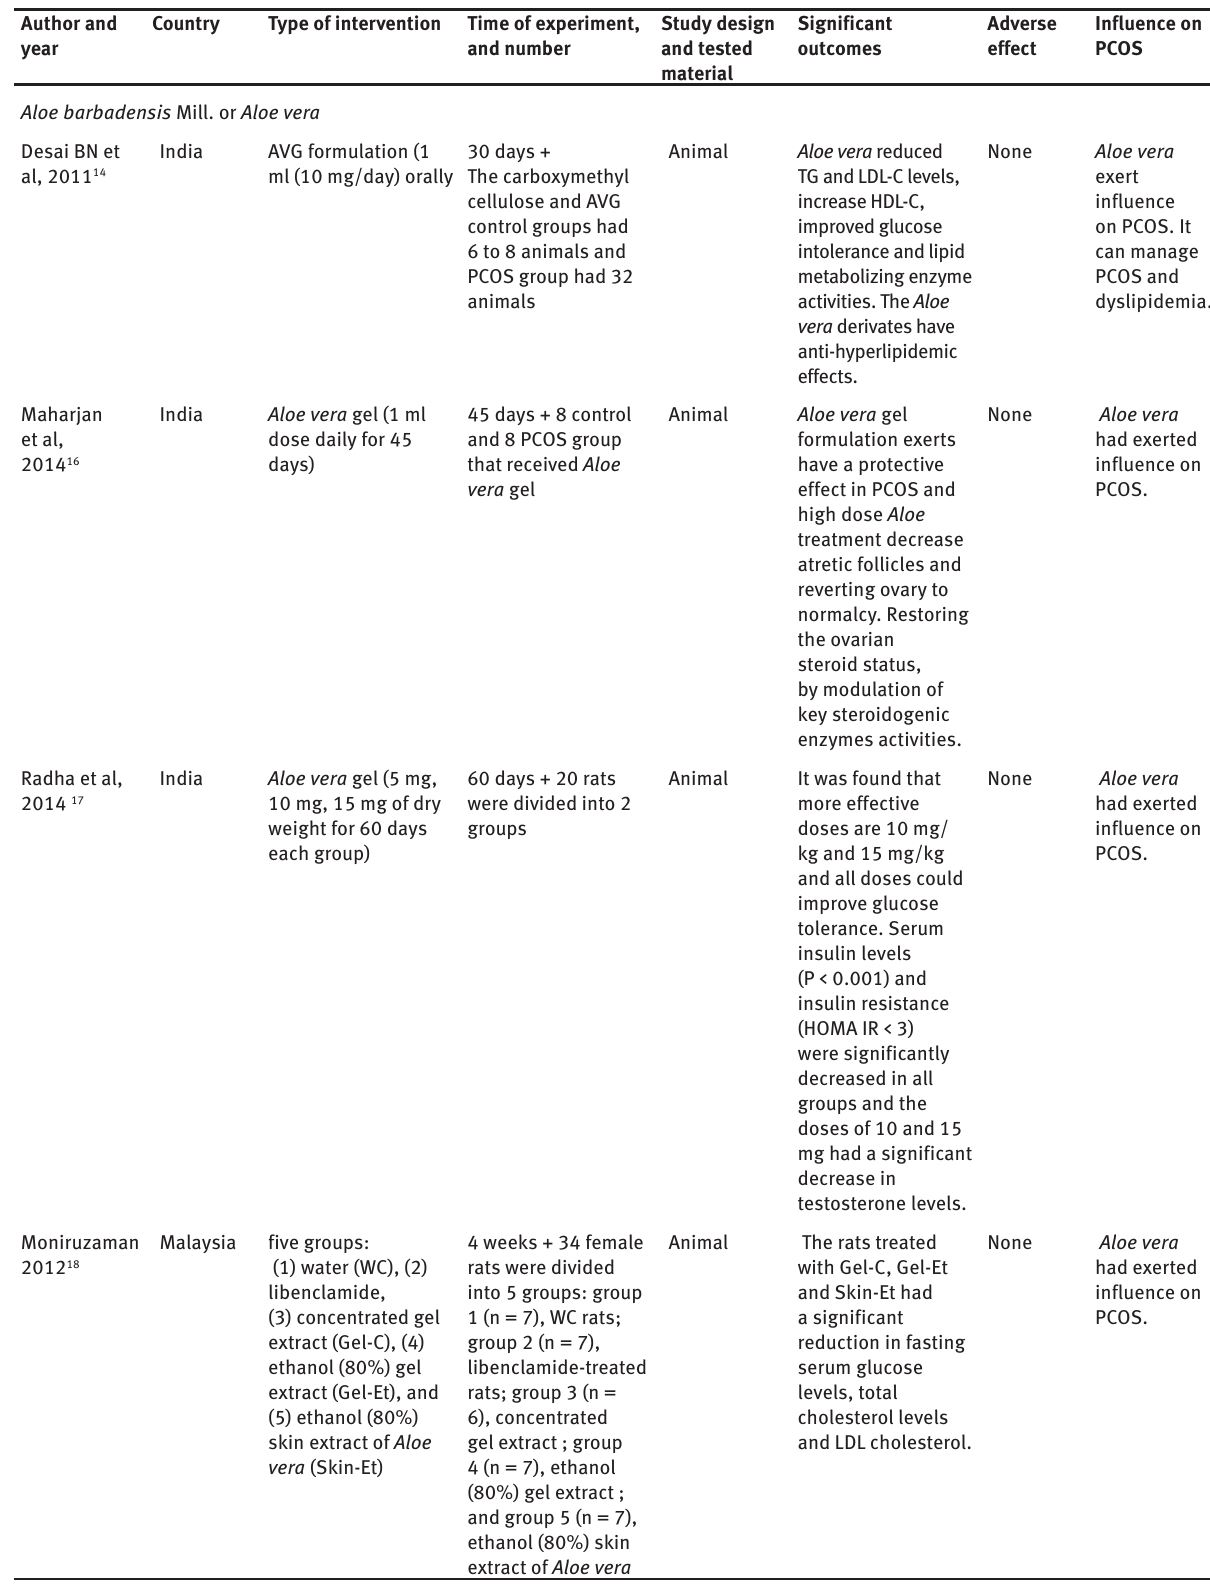
Influence on PCOSAdverse effectSignificant outcomesStudy design